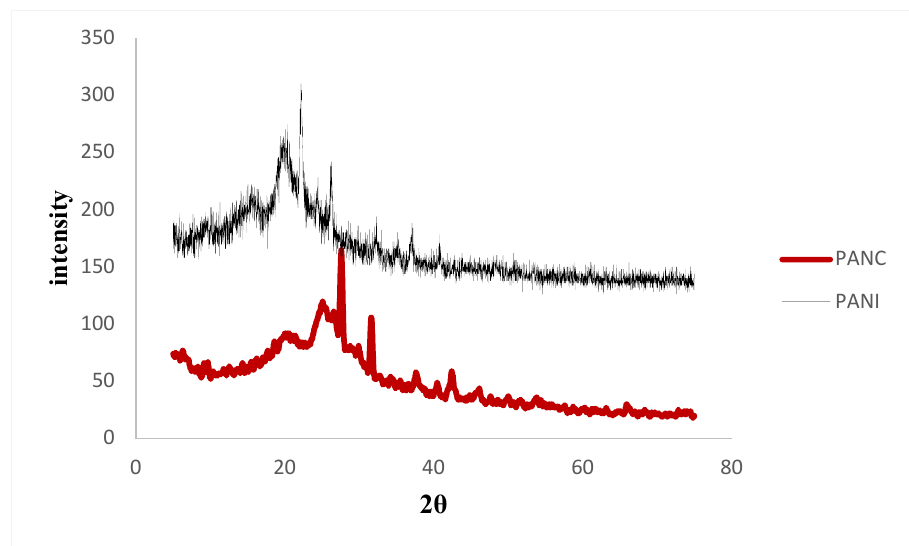
Figure 3. FTIR spectra for the PANI and PANC nanocomposite.